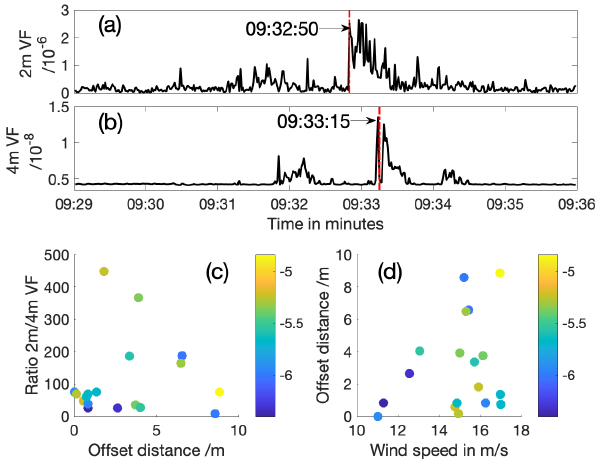
Figure 10. A typical offset between void fraction peaks at depths of 2m (a) and 4m (b) . The plume structure is very similar, although the void fractions in the two cases differ by 2 orders of magnitude and there is a clear offset of 25s. Panel (c) shows the offset dis- tance in metres for compared to the ratio between the peak void fraction and 2 and 4m. Marker colour shows log 10 (peak void frac- tion) of the camera measurement for each pair. All measured pairs are shown with the exception of two which had offsets of − 4 . 8 and 27m. (d) Wind speed at the time the offset was measured. Marker colour is the same as (c)